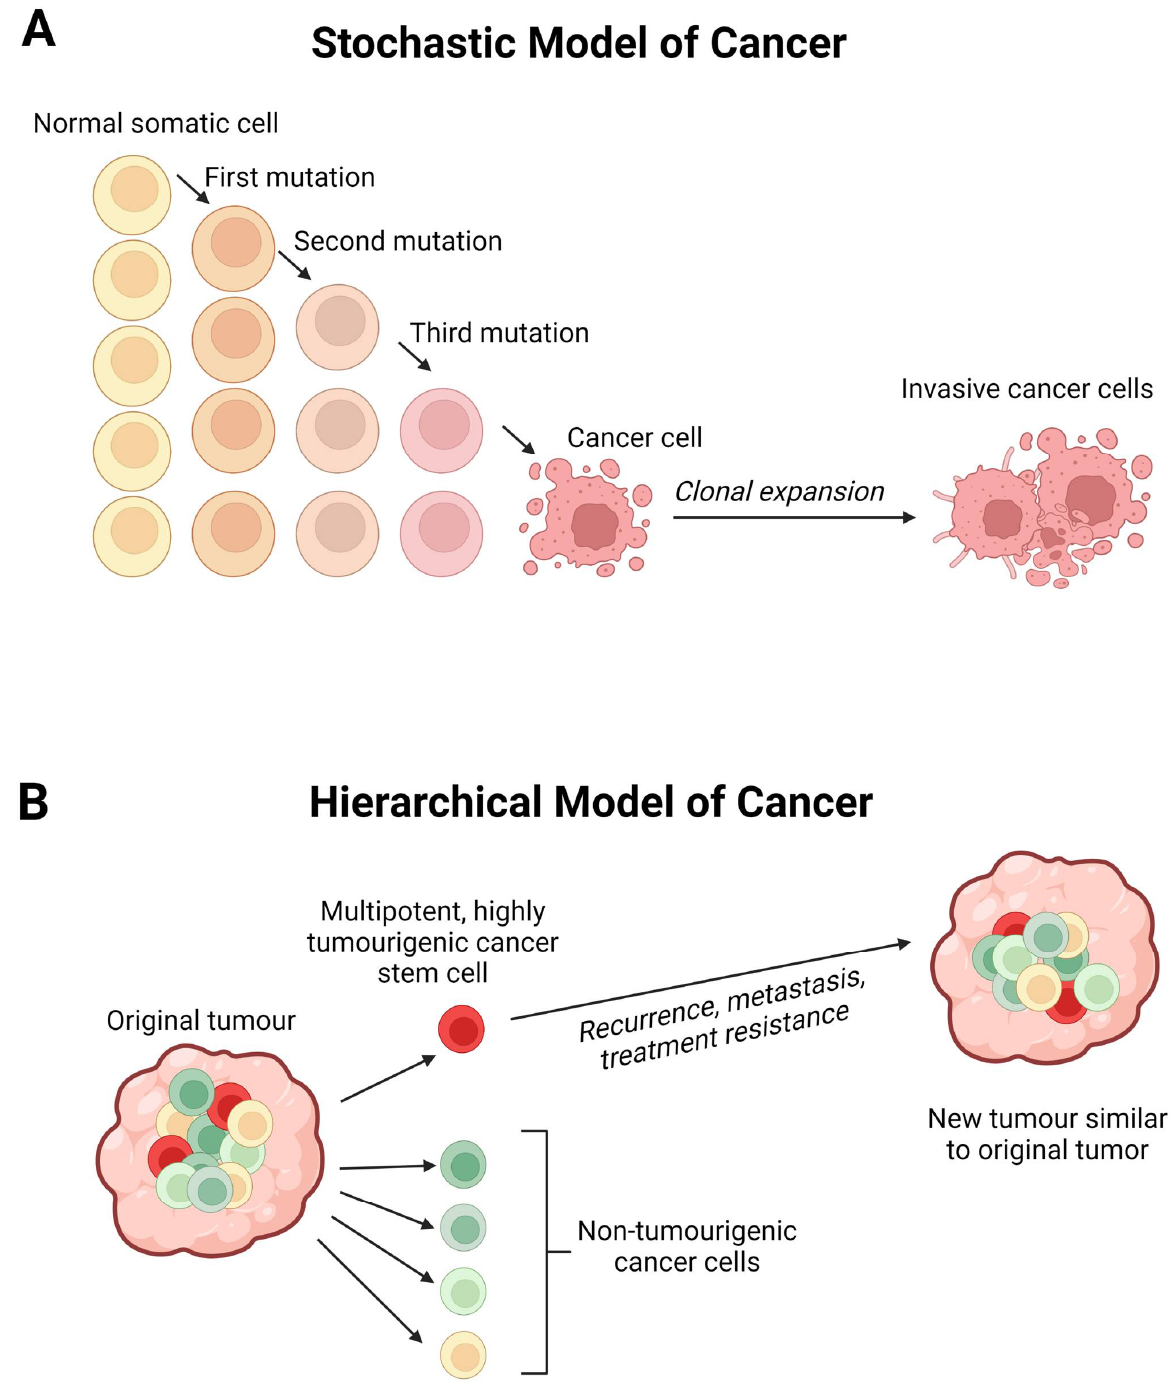
Figure 2. ( A ) The stochastic model of cancer proposes that a normal somatic cell accumulates oncogenic mutations in a stepwise manner and becomes a cancer cell that undergoes clonal expansion to form a tumour. ( B ) The hierarchical model of cancer proposes the presence of a highly tumourigenic cancer stem cell (CSC) sitting atop the tumour cellular hierarchy and divides asymmetrically to form non-tumourigenic cancer cells that form the bulk of the tumour, and identical CSCs that form new tumours like the original tumour. Created with Biorender.com accessed on 1 October